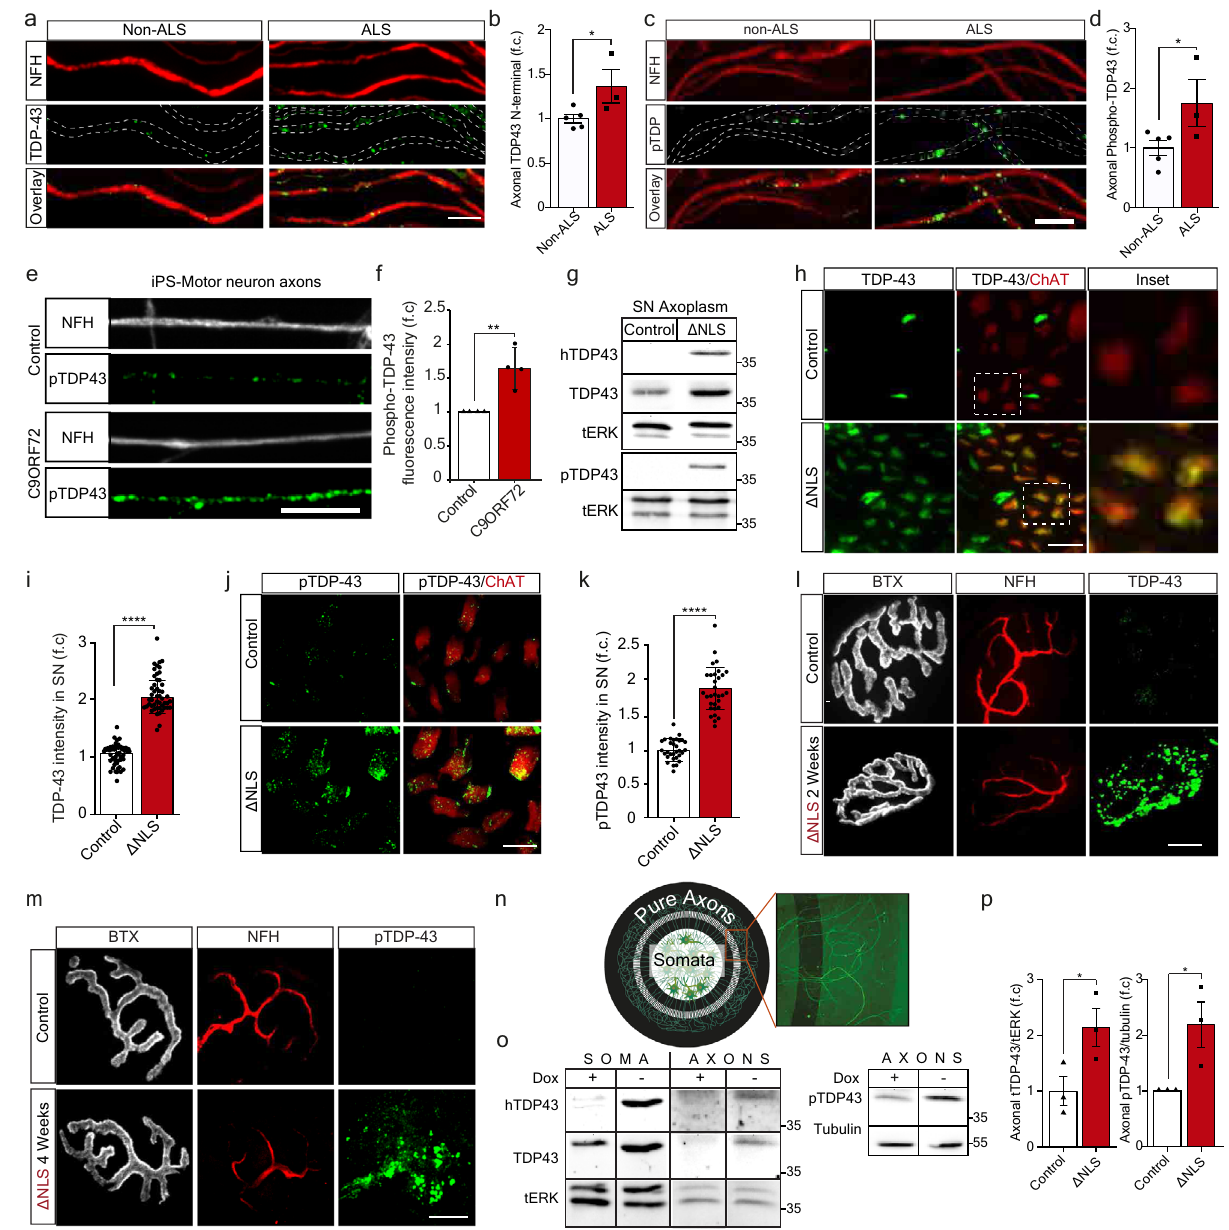
Fig. 1 TDP-43 mislocalizes to MN axons in ALS patients and TDP Δ NLS mice. a , c Immuno fl uorescence images and b , d Quanti fi cation of non-ALS and ALS patient intra-muscular nerves TDP-43 ( b ) or phosphorylated TDP-43 (pTDP-43) ( d ) signal within NFH-positive axons, normalized to NFH intensity. Scale bar = 10 µ m n = 5, 3 patients. Data are presented as mean values± SD. Unpaired- t -test, one-sided, * P = 0.026 ( b ),0.031 ( d ). e , f Images ( e ) and quanti fi cation ( f ) of pTDP-43 in axons (NFH) of C9ORF72 and control iPS-MN. Scale bar = 10 µ m. n = 210,181 axons. Data are presented as mean values ± SEM. Unpaired- t -test, two-sided. ** P = 0.0042. g Western-blots for TDP-43, human-speci fi c-TDP-43 (hTDP-43) and pTDP-43 in TDP Δ NLS and control mice sciatic nerve axoplasm (SN axoplasm). ERK1/2 (tERK) used as loading control. n = 3, 3 mice. h – k Images ( h , j ) and quanti fi cation ( i , k ) of TDP-43 ( h ) or pTDP-43 ( j ) intensity in ChAT-positive sciatic nerve axons of TDP Δ NLS ChAT::tdTomato and control ChAT::tdTomato mice. Scale bar = 20 µ m ( h ), 10 µ m ( j ). n ( h – i ) = 50,48, n ( j – k ) = 31,31 images from 3,3 mice. Data are presented as mean values ± SD. Unpaired- t -test, two-sided. **** P < 0.0001. l – m Images of TDP-43 ( l ) or pTDP-43 ( m ) in NMJs before, two-weeks ( l ) and four-weeks ( m ) after dox retraction from TDP Δ NLS mice diet. Bungarotoxin (BTX) and NFH mark the pre- and postsynaptic compartments respectively. Scale bar = 10 µ m. n ( l , m ) = 3,3 mice. n Radial MFCs structure. MNs axons (HB9::GFP) grow radially-outwards through microgrooves for large-scale protein/RNA puri fi cation. o , p Western-blots ( o ) and quanti fi cation ( p ) of hTDP- 43, TDP-43 and tERK (left), and pTDP-43 and tubulin (right) in protein lysates of TDP Δ NLS or control MNs/axons isolated from radial MFCs. n = 3 repeats. Data are presented as mean values± SEM. Unaired- t -test, one-sided, * P = 0.028 (left panel), Unpaired- t -test, two-sided, * P = 0.043 (right panel). f.c stands for Fold Change. Source data are provided as a Source Data fi